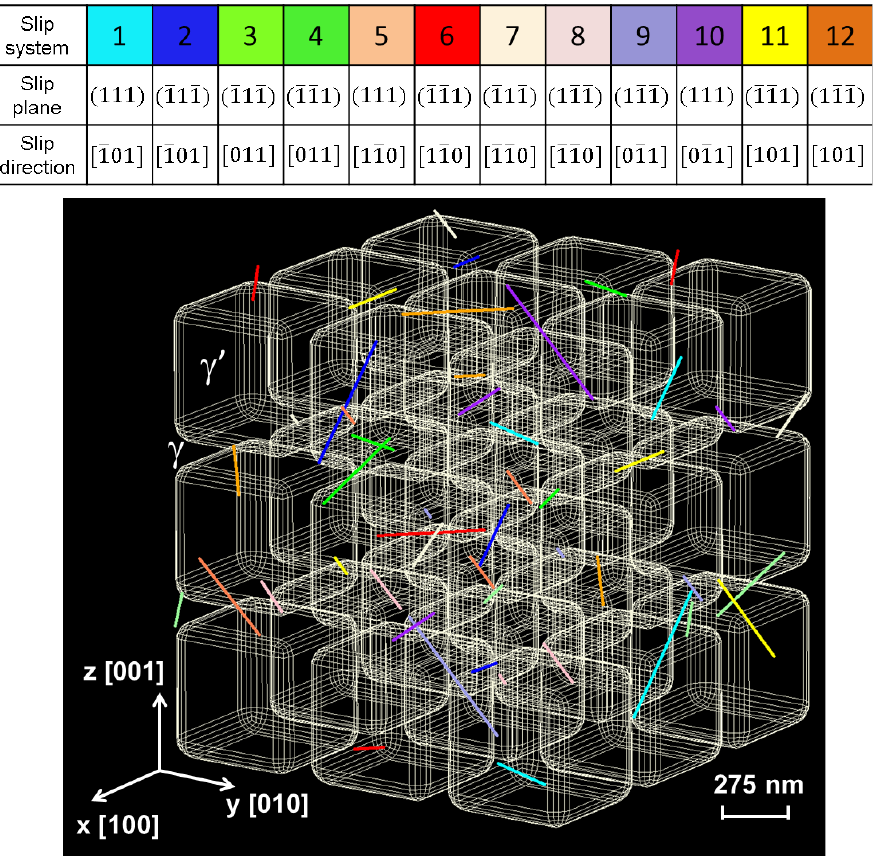
Figure 1. Representative γ / γ (cid:48) microstructure with uniformly distributed cuboidal γ (cid:48) precipitates surrounded by narrow γ matrix channels. Dislocation segments representing initial Frank–Read sources are distributed on 12 slip systems displayed by different colors as given in the color